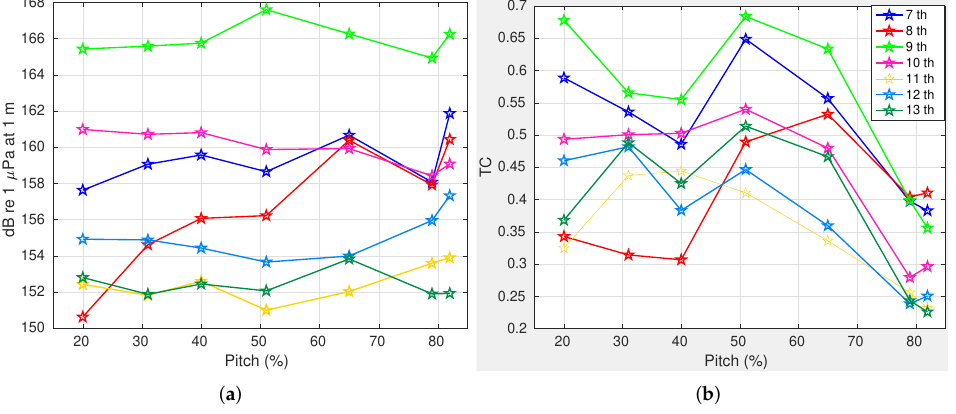
Figure 6. The ( a ) power spectral density (PSD) and ( b ) temporal coherence TC of the dominant 7th to 13th tonal harmonics of the cylinder firing rate (CFR) at different propeller pitch